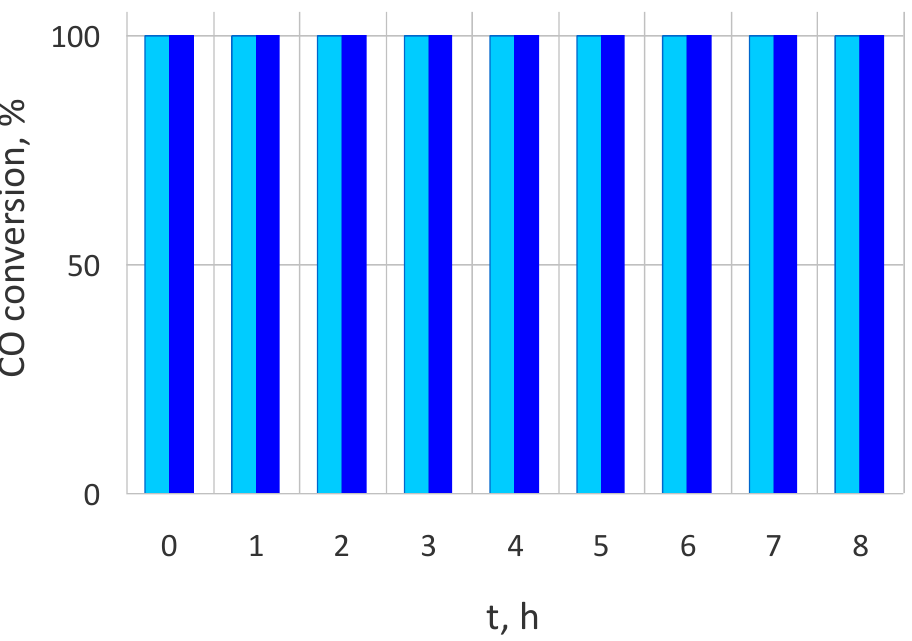
Figure 8. CO conversion over two Pt/Co/Z catalysts at 70 °C as a function of time . Close Pt contact with Co oxo-cations containing Co (II) and Co (III) changes the elec- tronic state of both metals. As recently found, the strong interaction between Pt and Co 3 O 4 resulted in an increase of the Pt 0 fraction in Pt-Co catalysts [76]. Similar results